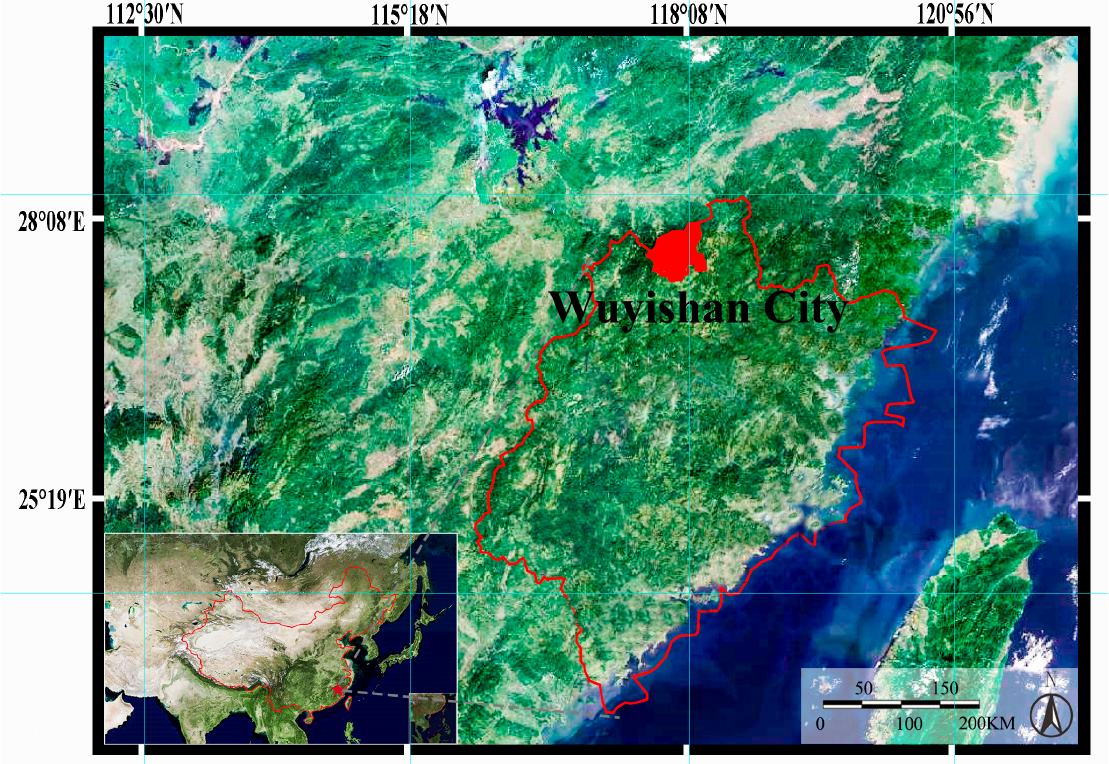
Figure 1. Location of study area